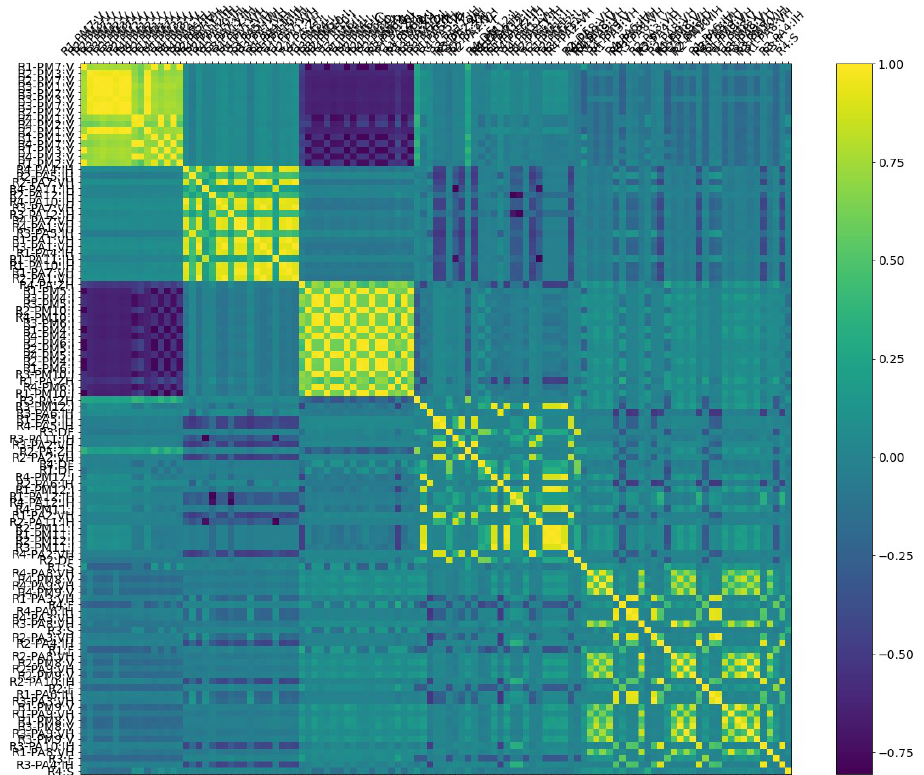
Figure 4. Correlation analysis matrix in Power System line maintenance (The X - and Y -axes are the same and show Power Systems